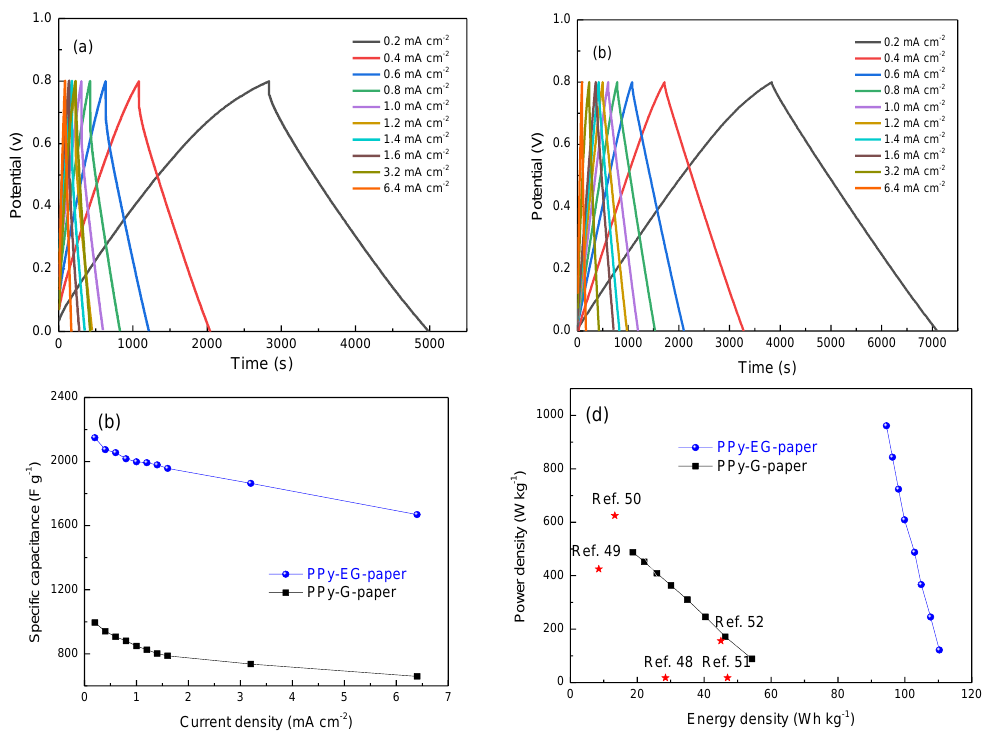
Figure 8. GCD curves of ( a ) PPy-G-paper and ( b ) PPy-EG-paper at different current densities; ( c ) specific capacitance of PPy-G-paper and PPy-EG-paper at different current densities; and ( d ) Ragone plots of PPy-G-paper and PPy-EG-paper.